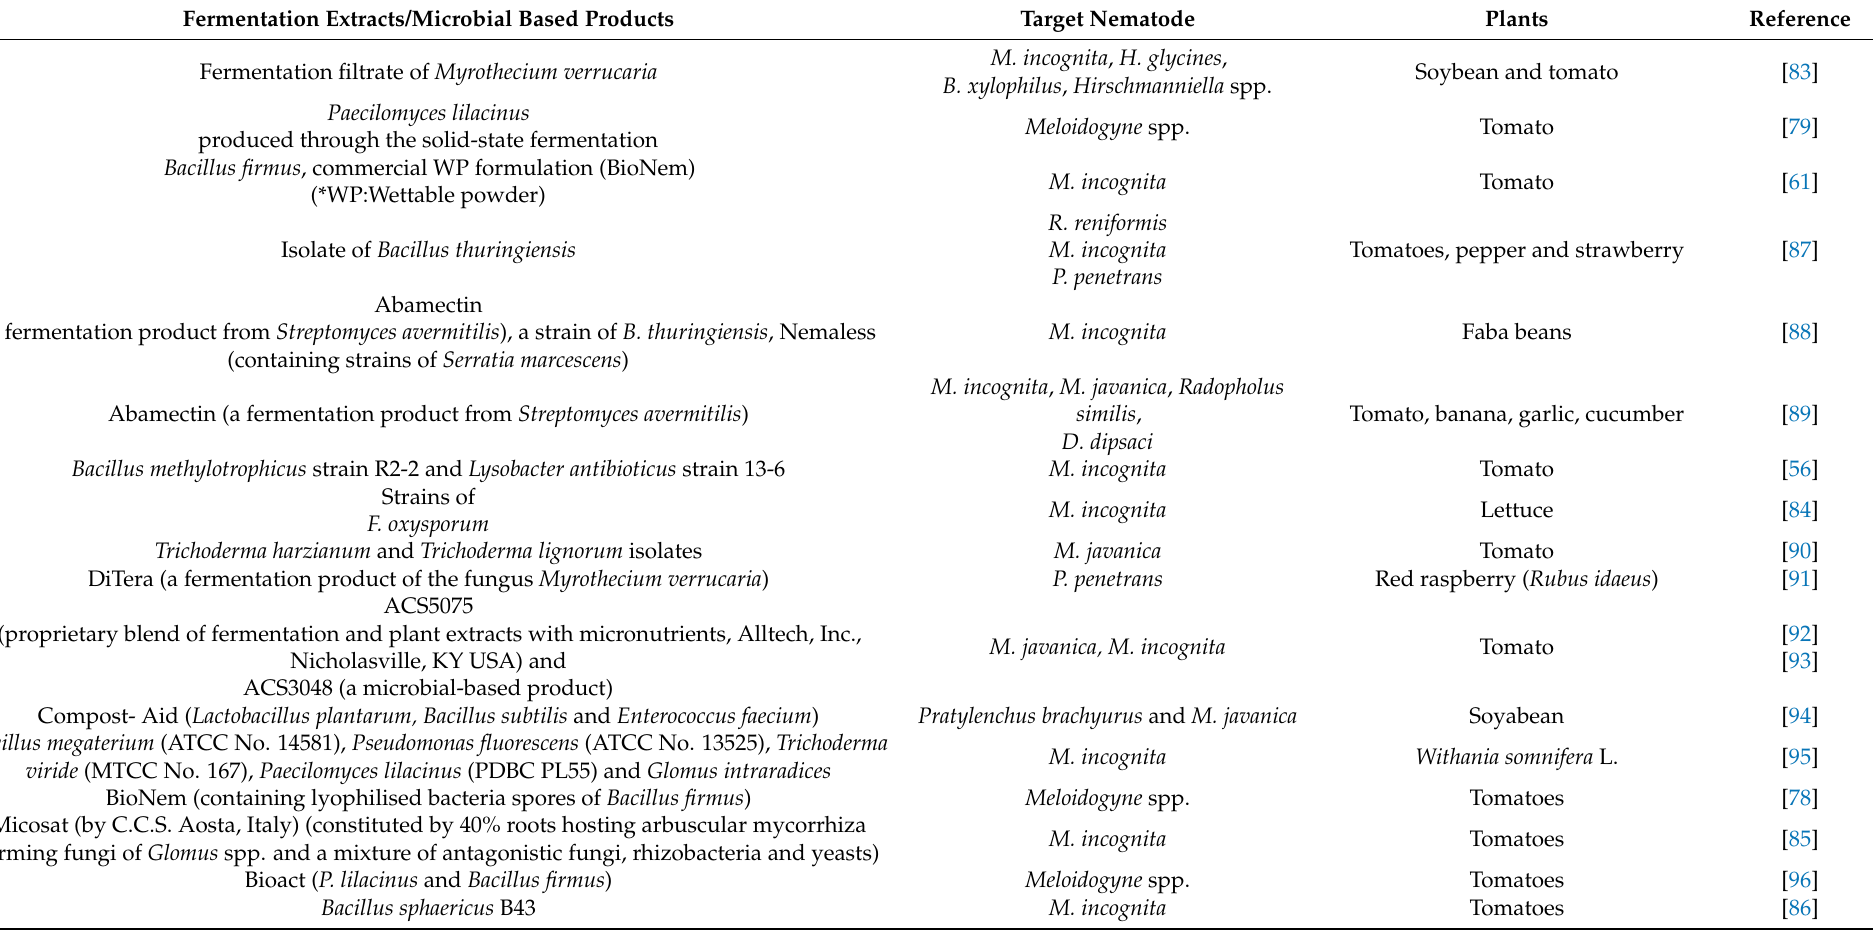
Table 4. Bionematicides based on biological control agents and fermentation